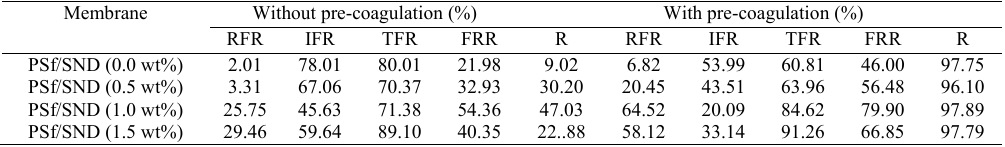
Table 3. Fouling and rejection parameters of prepared membranes during HA filtration with and without pre-coagulation process. Membrane Without pre-coagulation (%) With pre-coagulation (%)